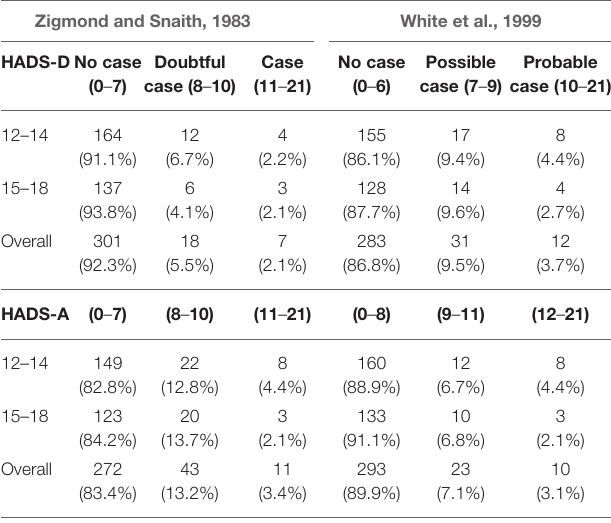
TABLE 3 | Identified cases as well as percentage for anxiety (HADS-A) and depression (HADS-D) depending on cut-off levels as reported by the literature. Zigmond and Snaith,